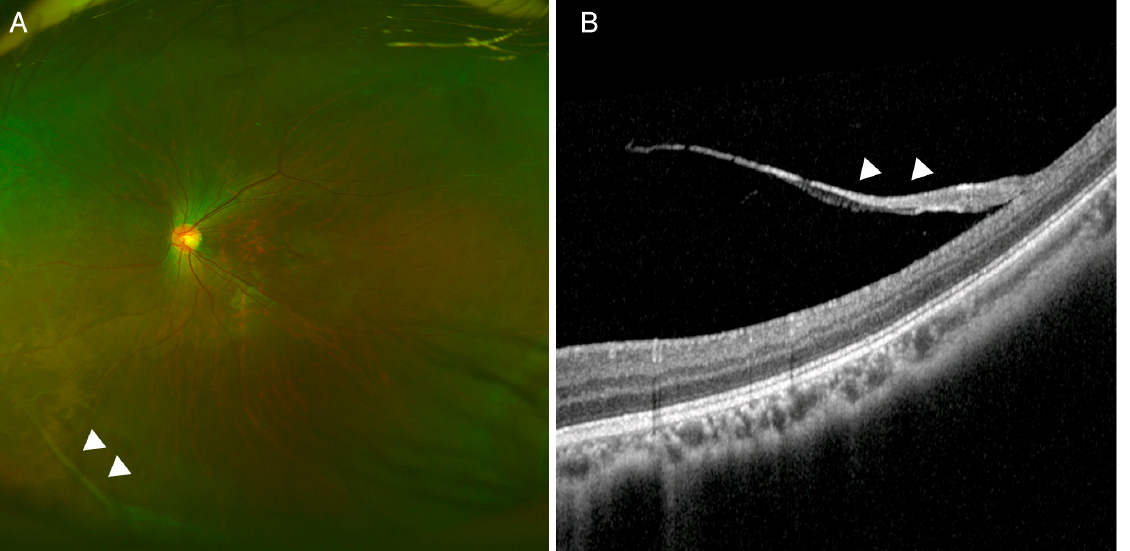
Figure 3. Fundus photography and optical coherence tomography (OCT) in a patient with Stickler syndrome (P12). ( A ) Peripheral vitreous degeneration was noted in wide fundus photography. ( B ) Spectralis OCT showed a thick vitreous band (arrowhead) attached to the retina. Targeted next- generation sequencing revealed a COL2A1 c.2680-3C>G variant, predicted to cause a new splicing acceptor site in intron 40. Prophylactic cryotherapy was applied to prevent retinal detachment.